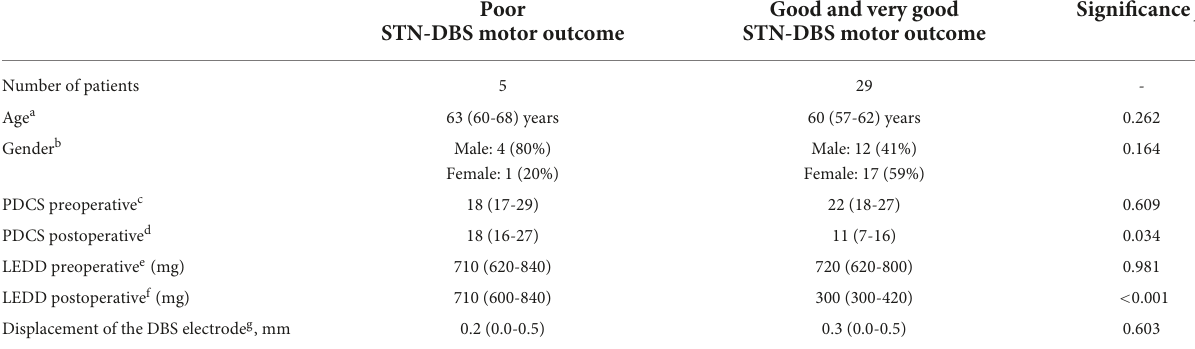
TABLE 1 Demographic data.